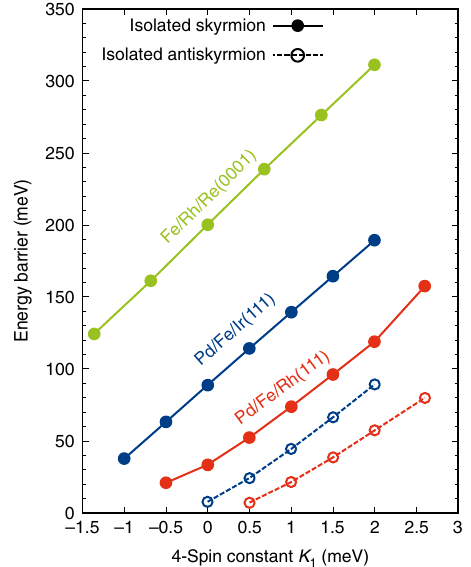
Fig. 5 Variation of energy barriers with four-site four spin constant. Energy barriers for skyrmions ( fi lled circles and solid lines) and antisykrmions (open circles and dashed lines) in the three considered ultrathin fi lm systems as a function of the strength and sign of the four-site four spin interaction constant. A constant magnetic fi eld is chosen for each of the systems: B = 5.2 T for Pd/Fe/Rh(111), B = 6 T for skyrmions and B = 4 T for antiskyrmions in Pd/Fe/Ir(111) and B = 3 T for